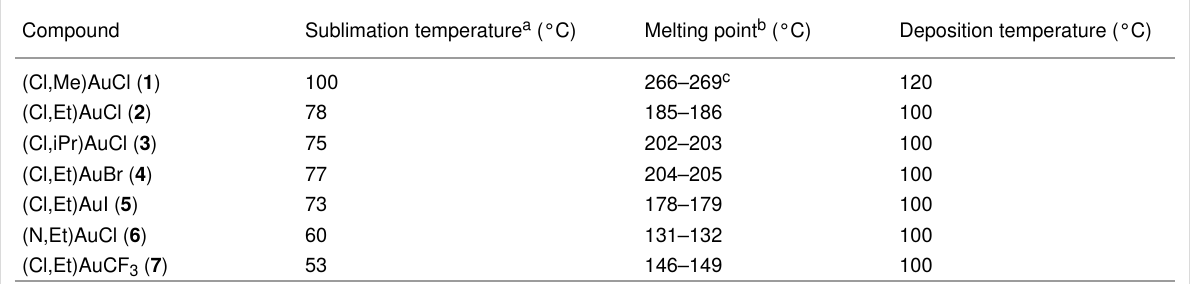
Table 1: Sublimation temperatures, melting points, and the chosen temperature for deposition of the studied precursors.